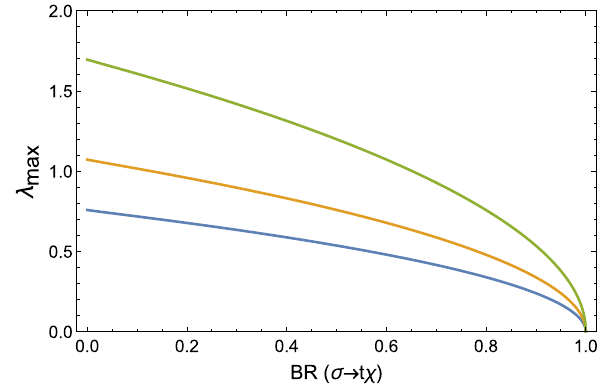
Fig. 6 Upper bound on λ as a function of BR t χ to obtain Γ tot / m σ ratios smaller than 10% (blue), 20% (orang) and 50%